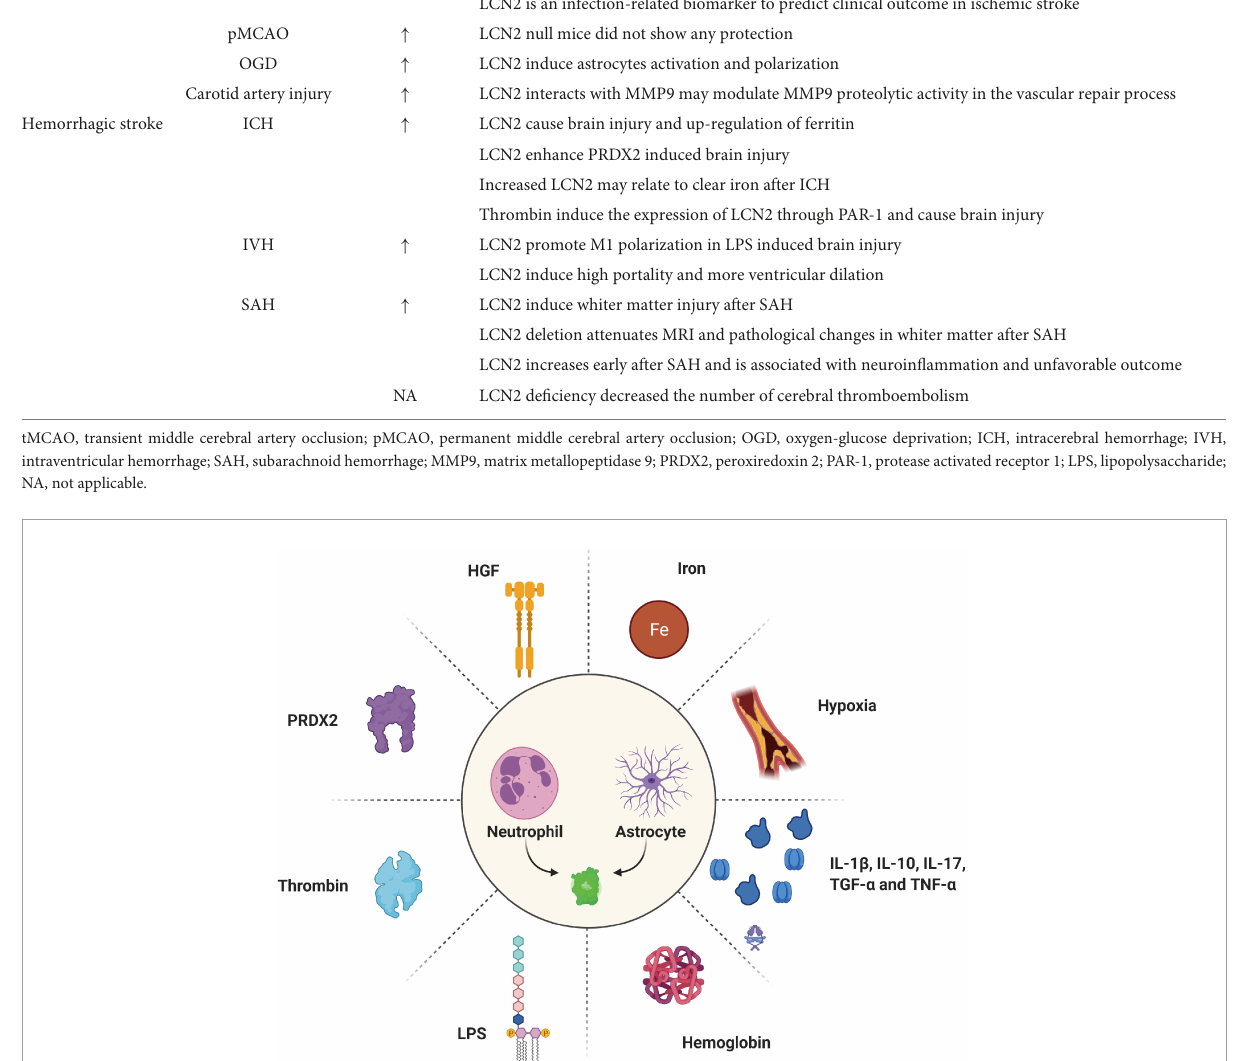
differences in infarct volume, brain edema, or neurological scores between the WT and LCN2 − / − groups in a permanent MCAO (pMCAO) model with no reperfusion. These results suggest that LCN2 might be involved in the progress of reperfusion injury after ischemic